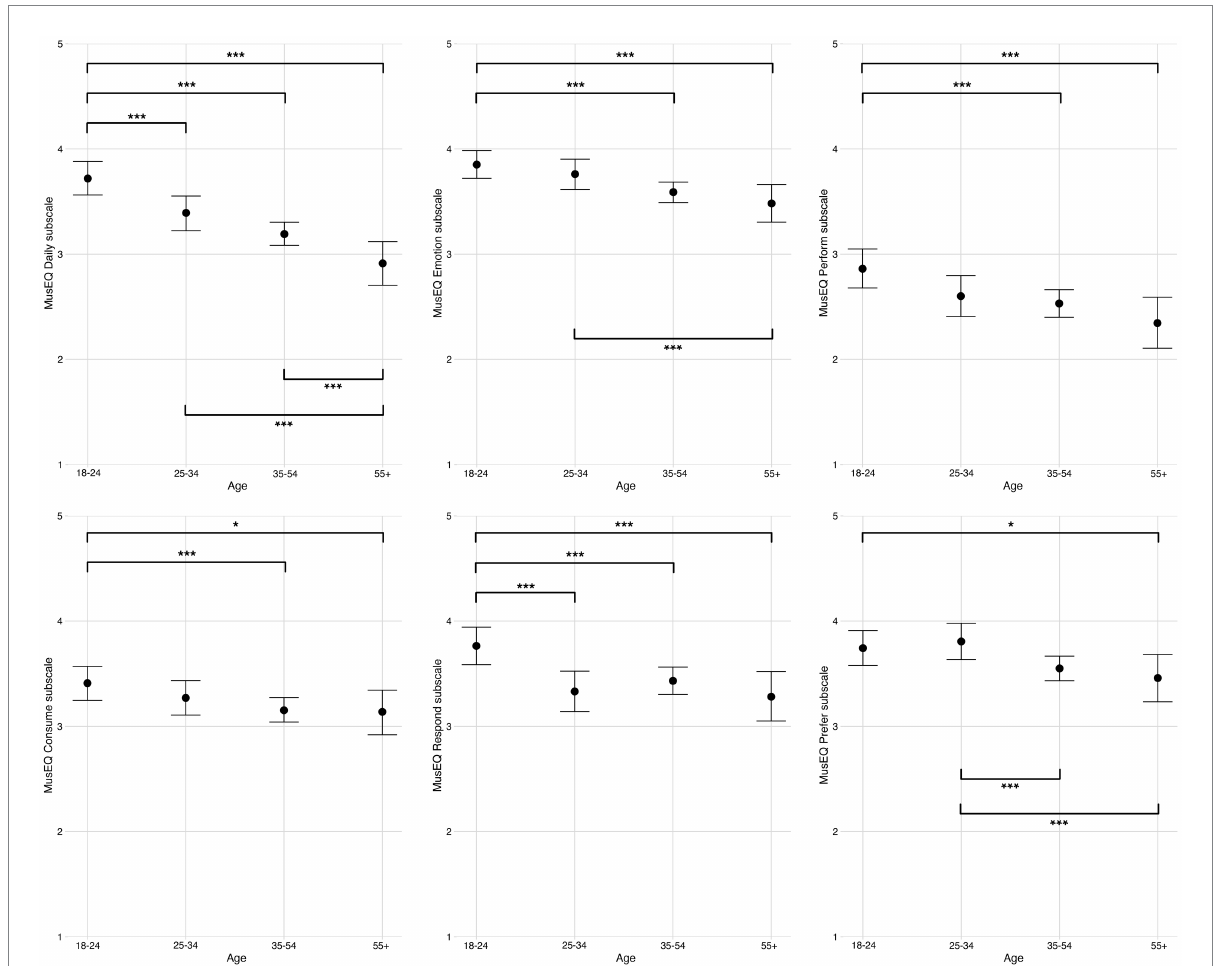
FIGURE 2 Ratings of the six MusEQ subscales, split across the four age groups. Error bars are 95% Bayesian credibility intervals. Additionally, evidence ratios 39–60 are denoted with *, evidence ratios 61–90 are denoted with **, and evidence ratios >90 are denoted with